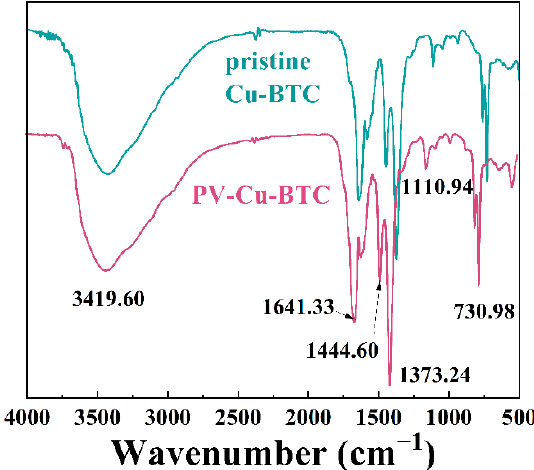
Figure 3. FT-IR spectra of pristine Cu-BTC and PV-Cu-BTC.